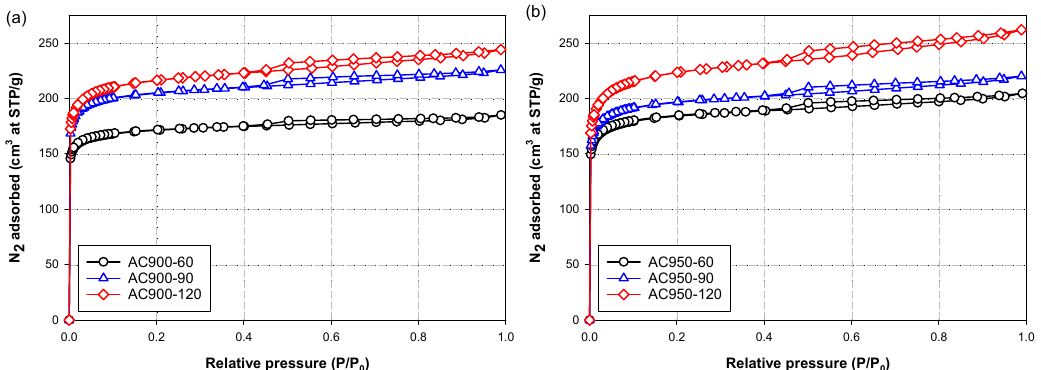
Figure 4. Effects of activation time on N 2 adsorption isotherms of activated carbon prepared by CO 2 activation at ( a ) 900 °C and ( b ) 950 °C for 60, 90 and 120 min . The activated carbons were derived from char carbonized at 600 °C and 90 min .